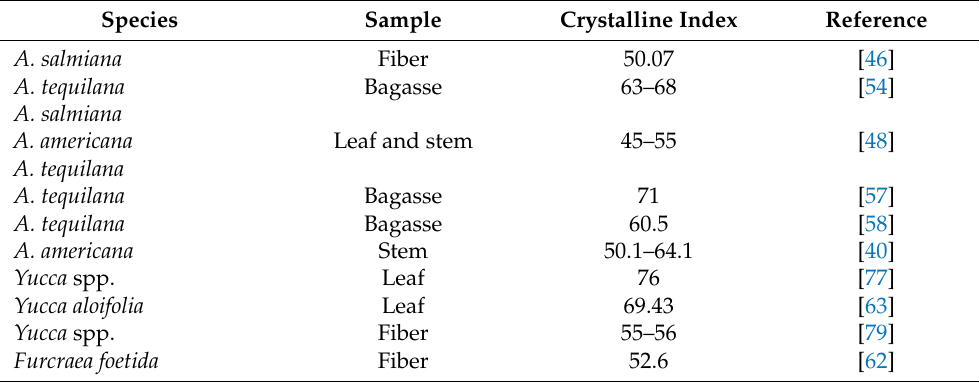
Table 10. Crystalline index Agave , Furcraea , and